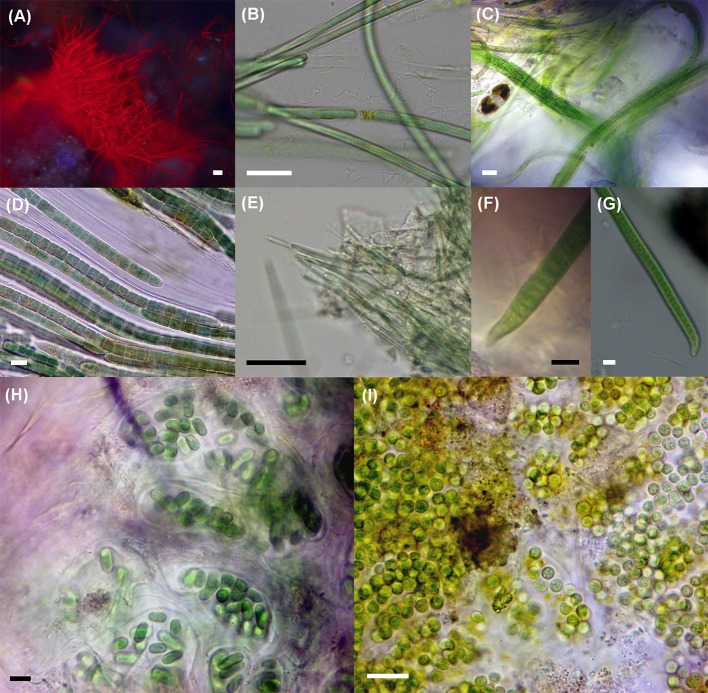
Epifluorescence (A) and bright field micrographs (B–I) showing ubiquitous, abundant, or dominant cyanobacteria in the environmental samples. (A) Tuft of filaments from Halomicronema excentricum, a thin cyanobacterium common to the three samples and abundant in the mat from EB2; (B)
Geitlerinema cf. lemmermannii, present in the three samples and being dominant at EB1 and abundant at EB3; (C)
Microcoleus aff. steenstrupii, abundant in EB1; (D)
Coleofasciculus chthonoplastes, a dominant species in mats collected at EB2 and EB3; (E)
Halomicronema excentricum; (F,G)
Oxynema cf. lloydianum abundant at EB3; (H)
Aphanothece cf. stagnina and (I)
Geminocystis sp. both common to all three samples. Scale bar: 10 μm.